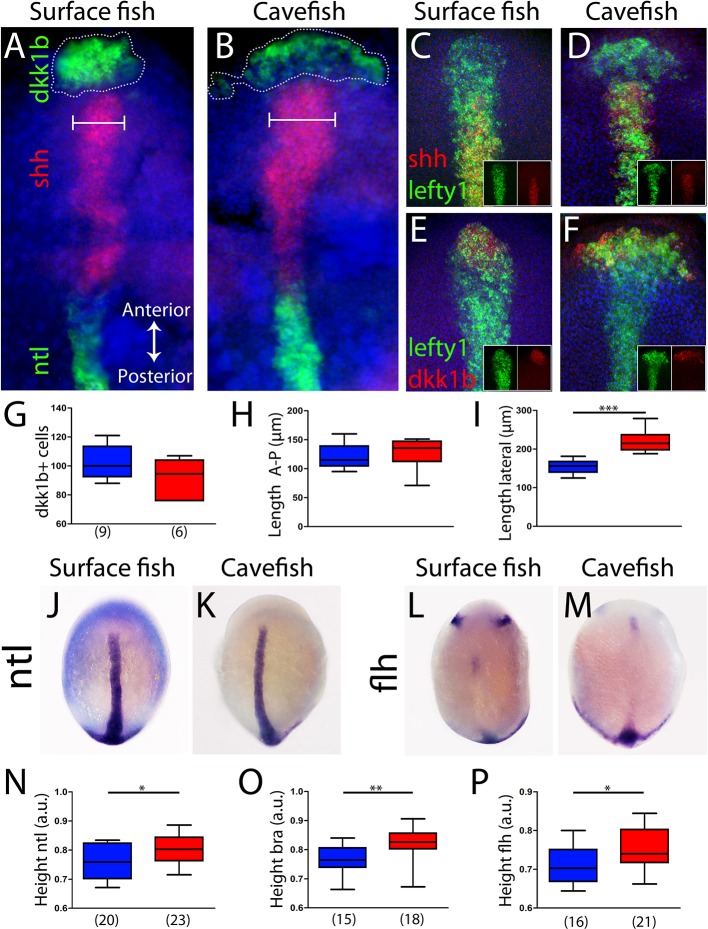
Axial mesoderm organization in surface fish and cavefish.(A, B) Triple ISH to dkk1b (green, rostral), shh (red, central) and ntl (green, posterior) in surface fish (A) and cavefish (B). (C, D) Confocal projection (20–30 µm) showing the expression of shh (red) and lefty1 (green) in surface fish (C) and cavefish (D) embryos. Insets show the individual channels. (E, F) Confocal projection (20–30 µm) showing the expression of dkk1b (red) and lefty1 (green) in surface fish (E) and cavefish (F) embryos. Insets show the split channels. (G) Quantification of the number of cells expressing dkk1b. (H) Quantification of the distance between the dkk1b-expressing cells located in the extremes of the antero-posterior axis. (I) Quantification of the distance between the dkk1b-expressing cells in lateral extremes. (J, K) Expression of ntl in surface fish (J) and cavefish (K). (L, M) Expression of flh in surface fish (L) and cavefish (M). (N) Quantification of height in ntl-labeled embryos. (O) Quantification of height in bra-labeled embryos. (P) Quantification of height in flh-labeled embryos. All embryos at tail-bud stage, in dorsal view, anterior upwards. Pictures in panels (A–F) are flat mounted embryos, whereas pictures in panels (J–M) are whole-mount embryos. Mann-Whitney tests were performed. ***, p = <0.0001 (I); *, p = 0.0396 (N); **, p = 0.0012 (O); and *, p = 0.0142 (P).